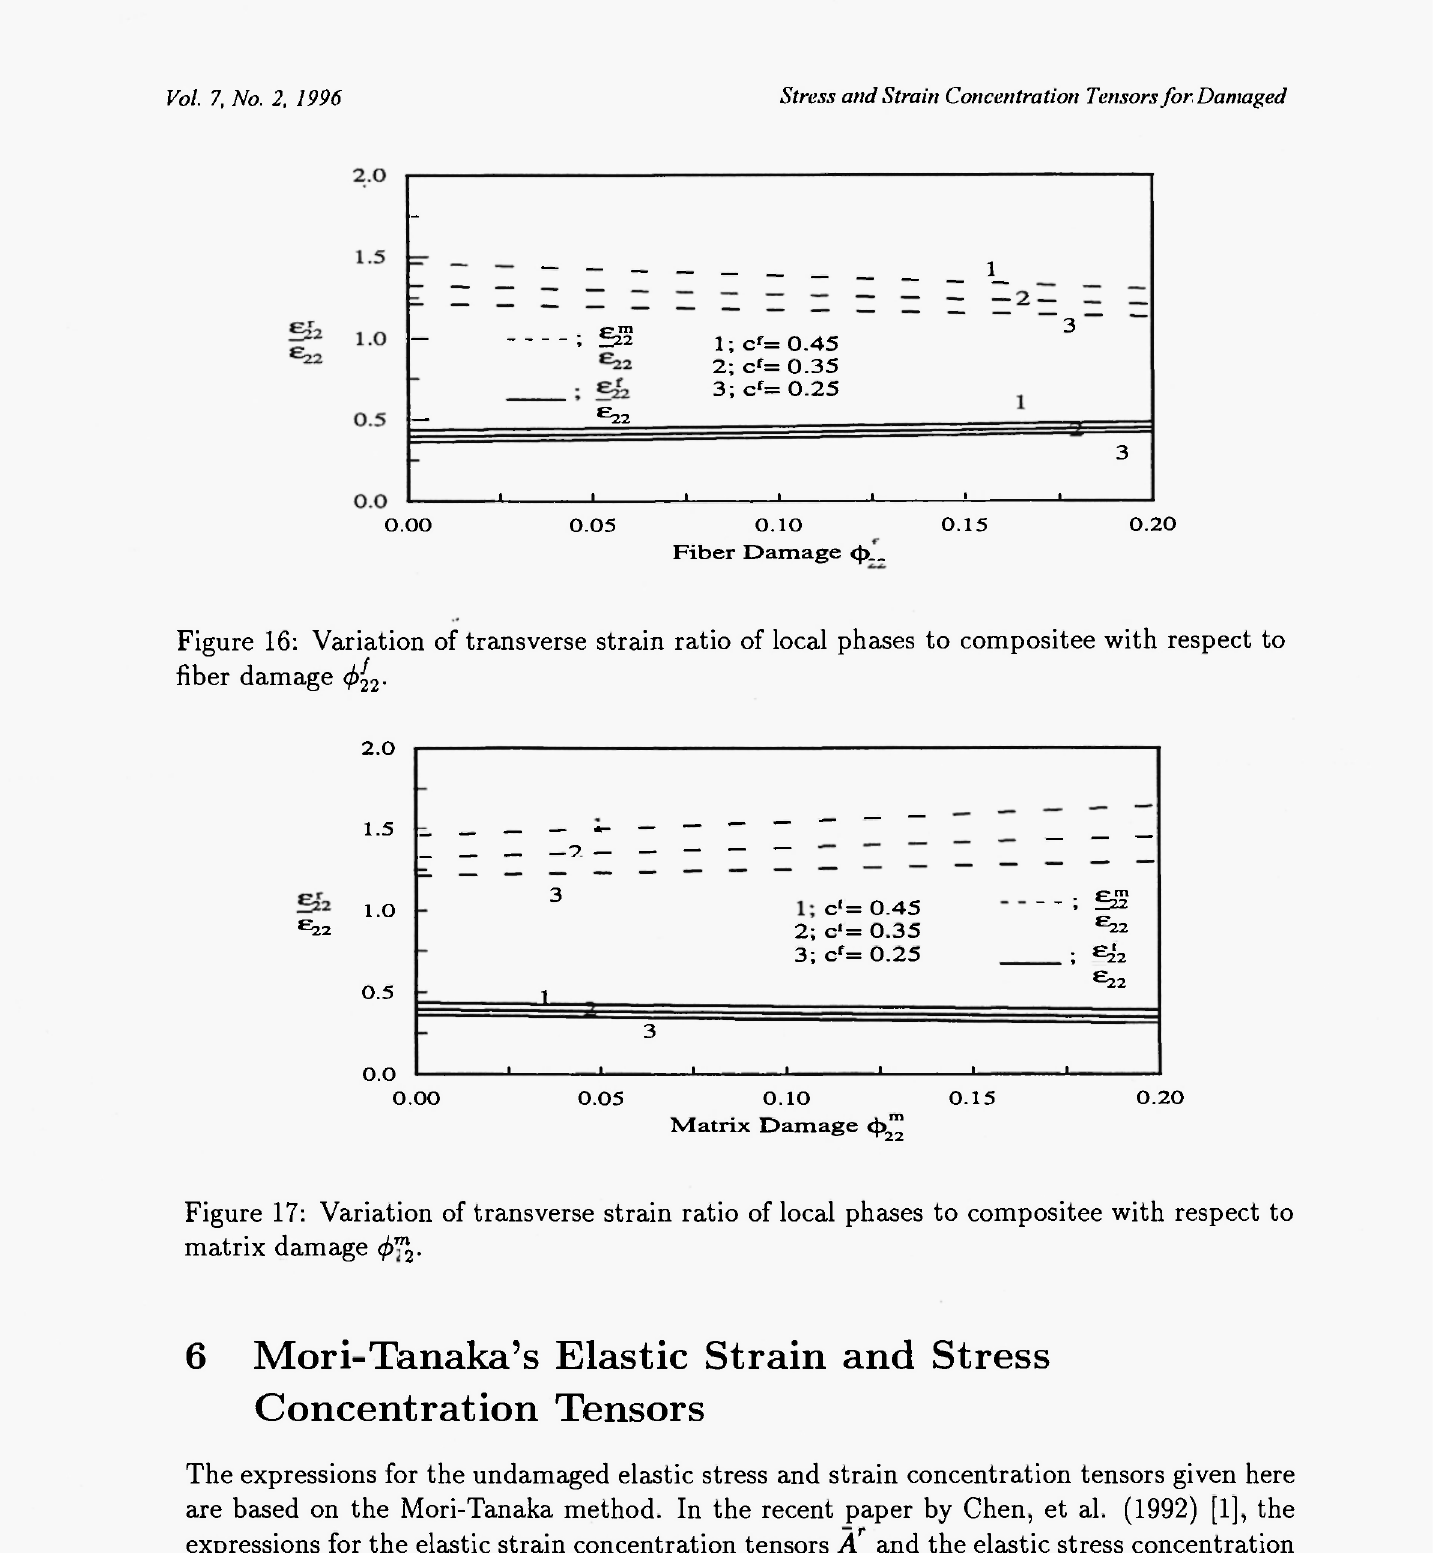
Figure 16: Variation of transverse strain ratio of local phases to compositee with respect to fiber damage φ{ 2 .